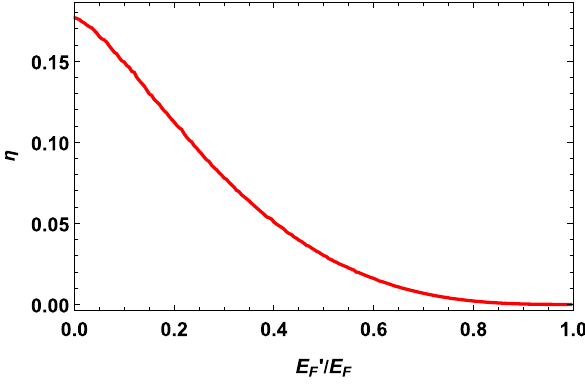
Fig. 3 Pauli blocking factor η as a function of E (cid:2)